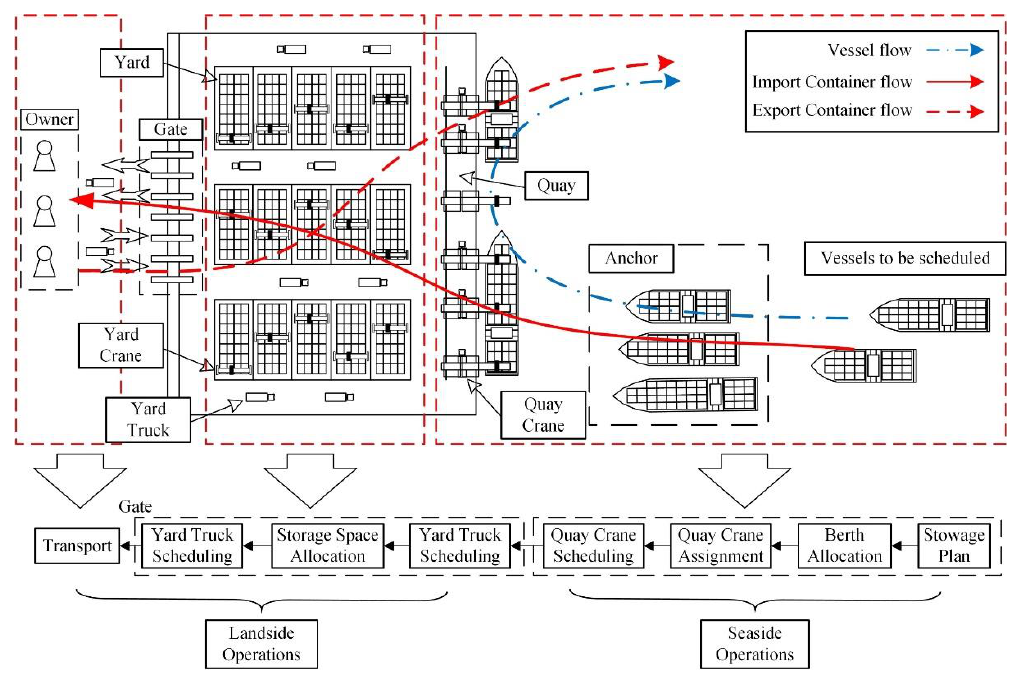
Figure 1. Container terminal workflow. (Source: compiled by the authors).